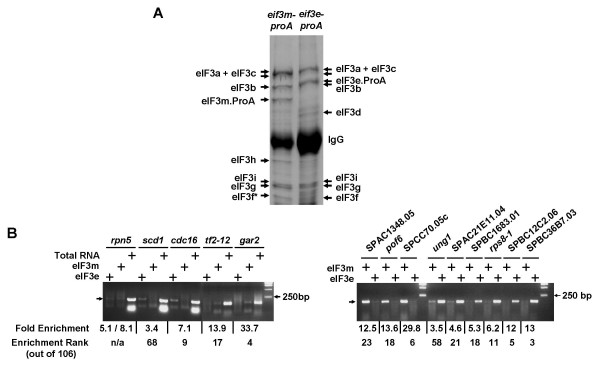
Specific association of mRNAs with the eIF3e and eIF3m complexes. (A) The eIF3 complexes shown were affinity-purified as described in the Methods section, and separated by SDS-PAGE followed by staining with Coomassie Brilliant Blue. The labeled bands were identified by LC-MS/MS. eIF3f* refers to a band in the eIF3m complex that was not identified by mass spectrometry in this experiment, and is therefore assigned based on its comigration with eIF3f identified in the eIF3e complex (right lane). eIF3f was positively identified by MALDI-TOF mass spectrometry as a subunit of the eIF3m complex in Fig. 1B. (B) The indicated eIF3e- and eIF3m-associated mRNAs were extracted from the purified complexes and employed in RT-PCR reactions using primers specific for each mRNA (see Table 3). PCR products obtained with total S. pombe RNA are shown for reference in the left panel. The factor of enrichment of each mRNA in the respective eIF3 complex and the enrichment rank (out of all 106 mRNAs enriched in either complex) are indicated below the gels.